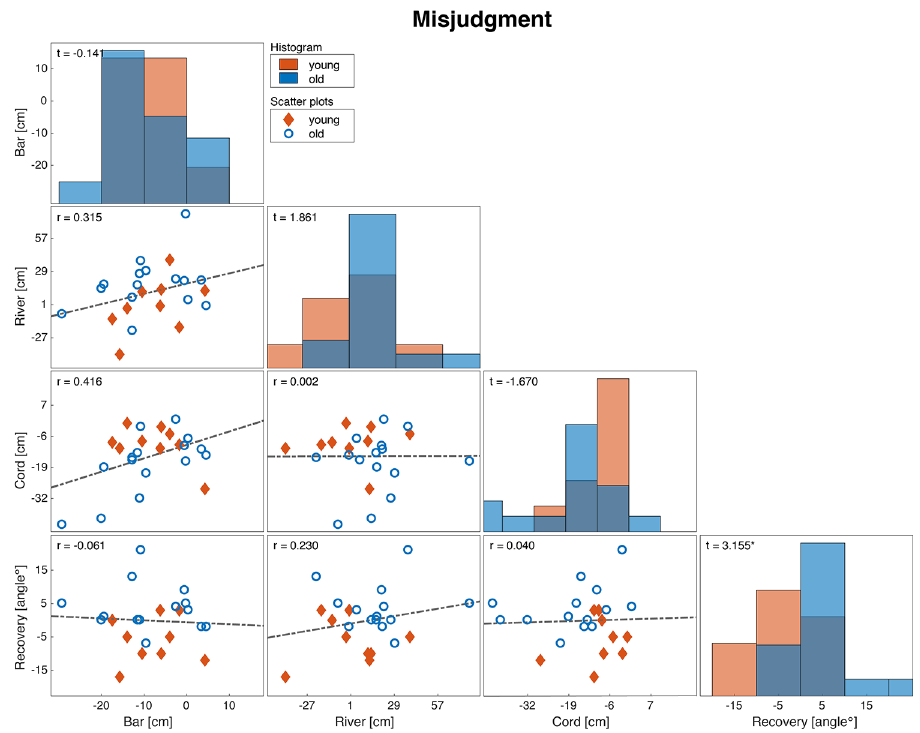
Fig 5. Distribution and consistency matrix of the degree of misjudgment over tasks. The diagonal panels(histograms) show the distributionof the misjudgmentfor the two age groups, where the off-diagonal panels(scatter plots) show the correlationin the degreeof misjudgment betweentasks. Diamondsrepresent youngadults and circles represent older adults. Corresponding correlationcoefficientsand t-tests (i.e., testing the differences betweenyoungand older adults) are indicatedin the top-left corner of each panel ( * :p < 0.05, ** :p < 0.01, *** :p < 0.001).